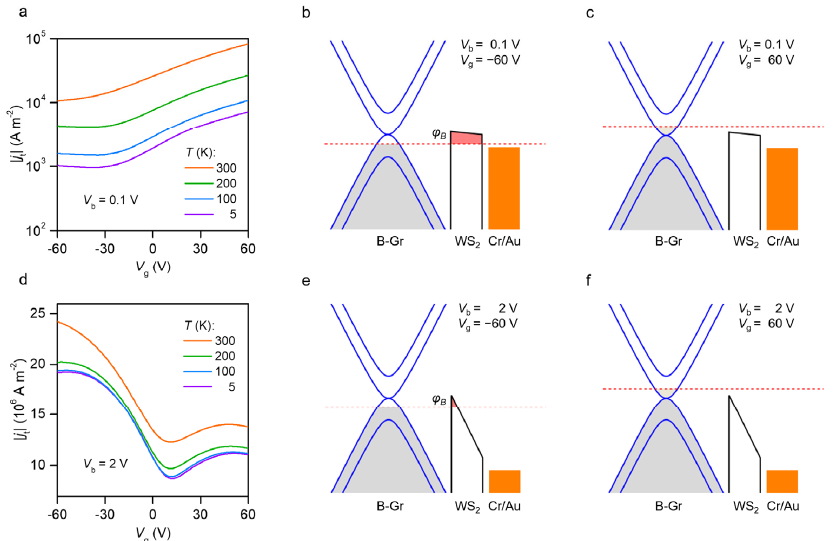
Figure 3. Controlling the carrier transport polarity in GWMH tunneling devices. ( a – c ) The transfer curves of the GWMHs device at low bias ( V b = 0.1 V) and the corresponding energy band diagrams under V g = − 60 V and V g = 60 V, respectively. ( d – f ) The transfer curves of the GWMHs device at low bias ( V b = 2 V) and the corresponding energy band diagrams under V g = − 60 V and V g = 60 V, respectively. The red dash line is the Fermi level of the bottom graphene.